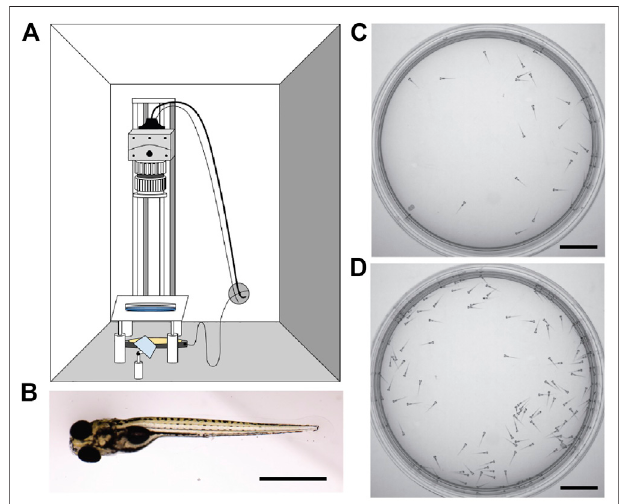
FIGURE 1 | Experimental observation of larval zebra fi sh swimming collectively at various densities. (A) Schematic of experimental set-up. (B) Imageofalarval zebra fi sh at 6 days post-fertilization, scale bar 1 mm. Rostral (head) is to the left. (C) 30 larval zebra fi sh in the arena as captured by the camera. (D) 130 larval zebra fi sh in the arena. Scale bar for C-D 1